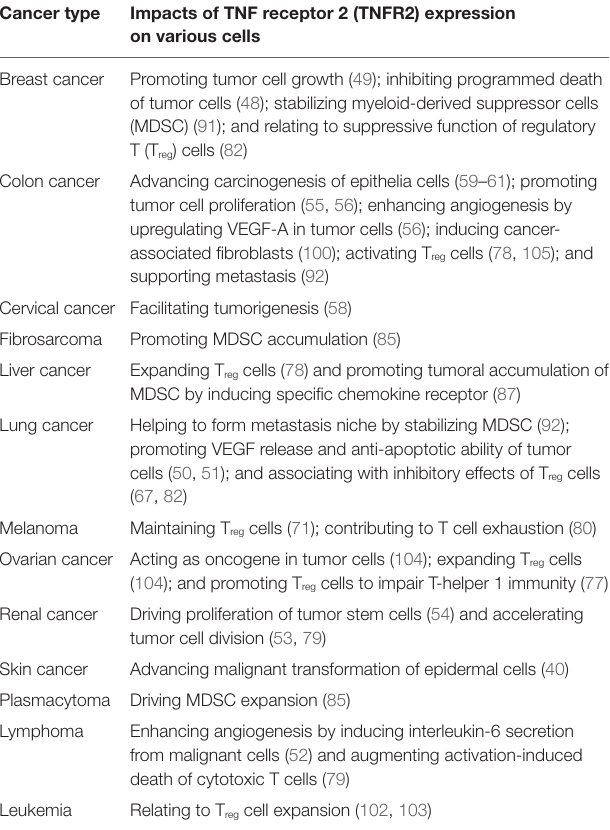
TAble 1 | Tumor development promoted by TNFR2-mediated signaling in tumor or tumor-associated cells. Cancer